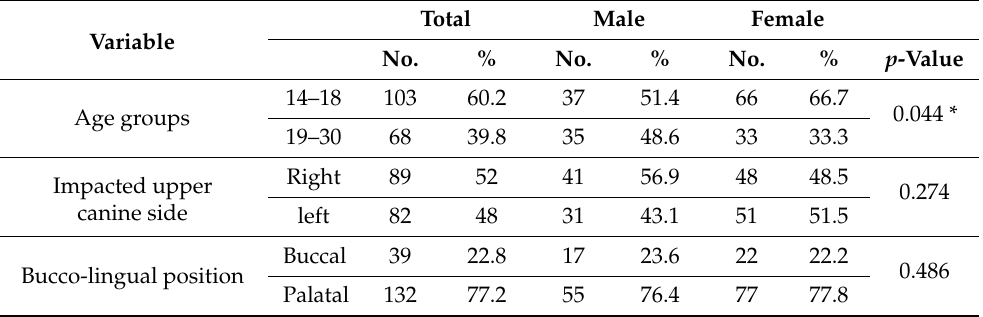
Table 2. Distribution and comparison of age and impacted canines between male and female study subjects (N =